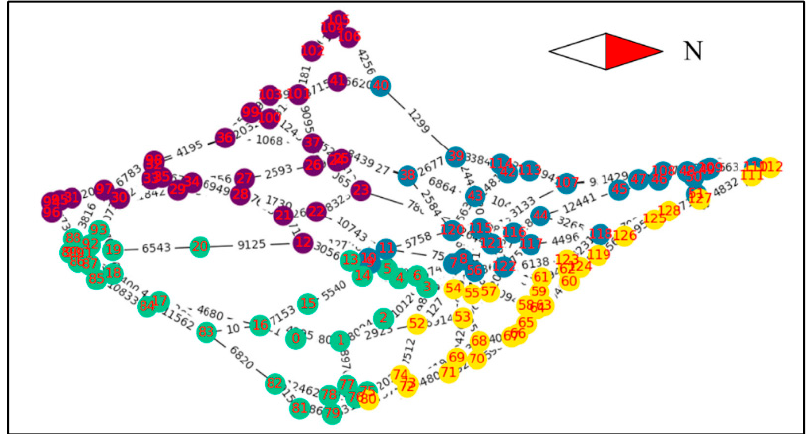
Figure 3. Network clustering with four zones/clusters.